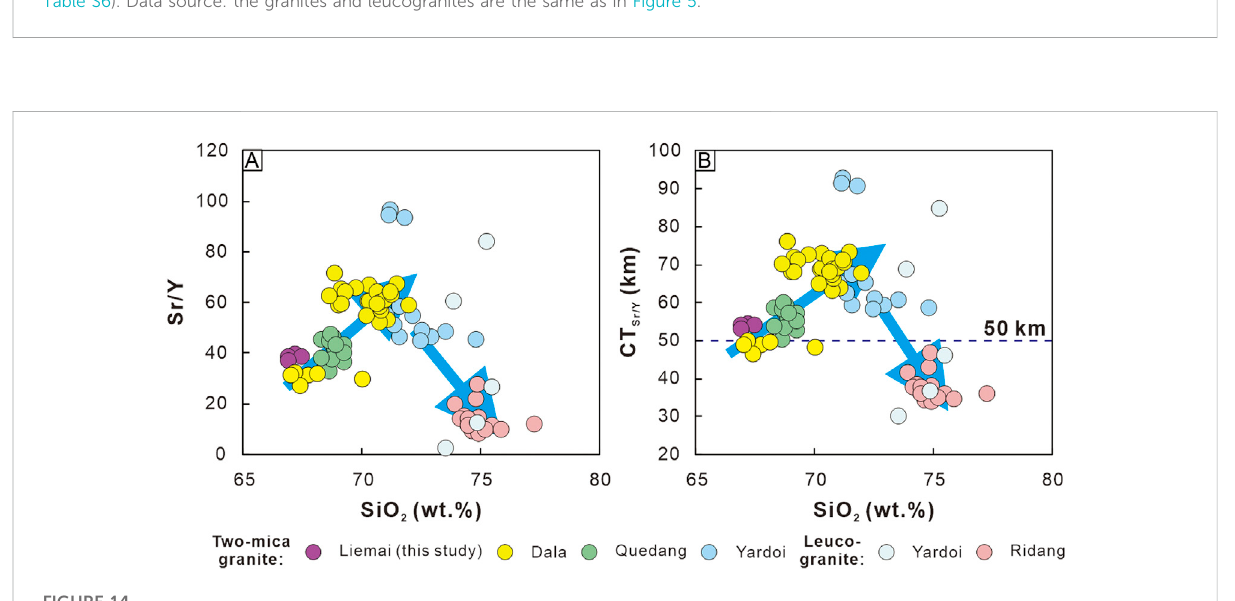
FIGURE 13 Ba-Sr modeling of melt extraction from the Early Eocene two-mica granite crystal mush for the generation of the coeval leucogranites in the Yardoi area. The detailed modeling process can be found in Liu et al. (2019), and the related calculation parameters are presented in Supplementary Table S6). Data source: the granites and leucogranites are the same as in Figure